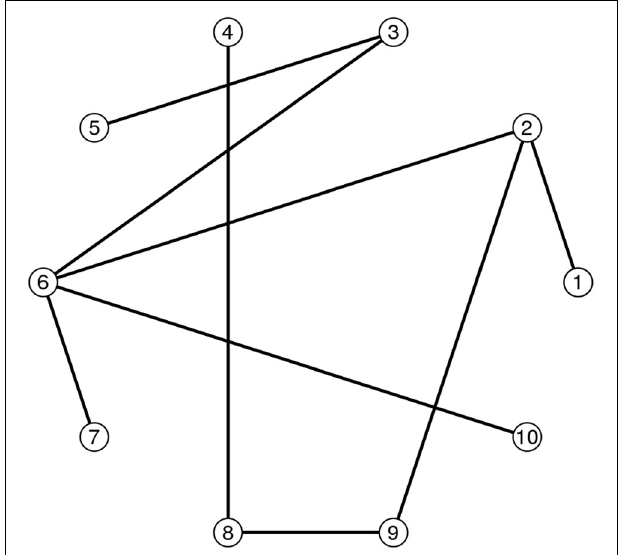
FIGURE 4 | An illustration of a Minimum Spanning Tree linking 10